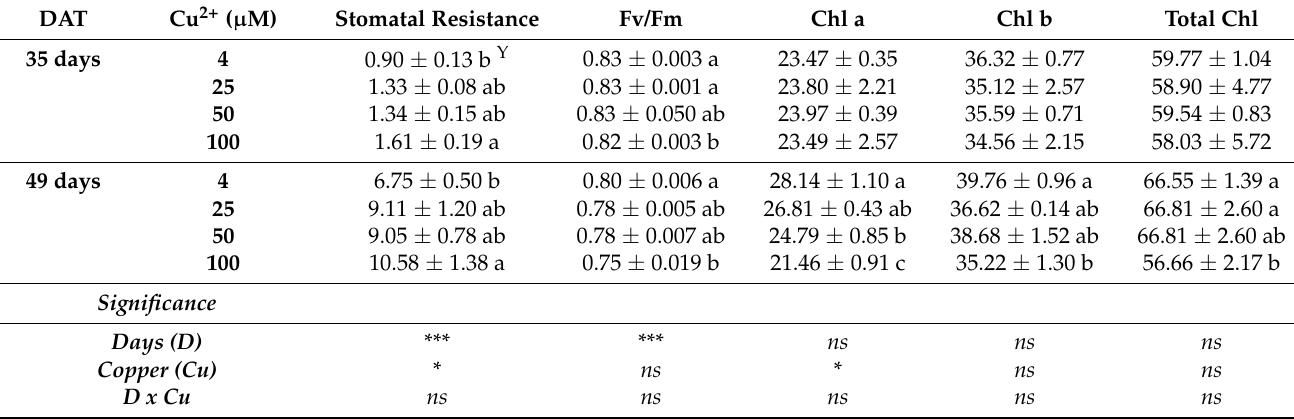
Table 2. Effect of increasing copper (Cu) concentration (4–25–50–100 μ M Cu 2+ ) in the nutrient solution and sampling date after transplanting-DAT (35 days and 49 days) on leaf stomatal resistance (cm s − 1 ), chlorophyll fluorescence (Fv/Fm), chlorophylls (Chl a, Chl b, Total Chl) content ( μ g g − 1 fresh weight) in pelargonium plants grown hydroponically in perlite.